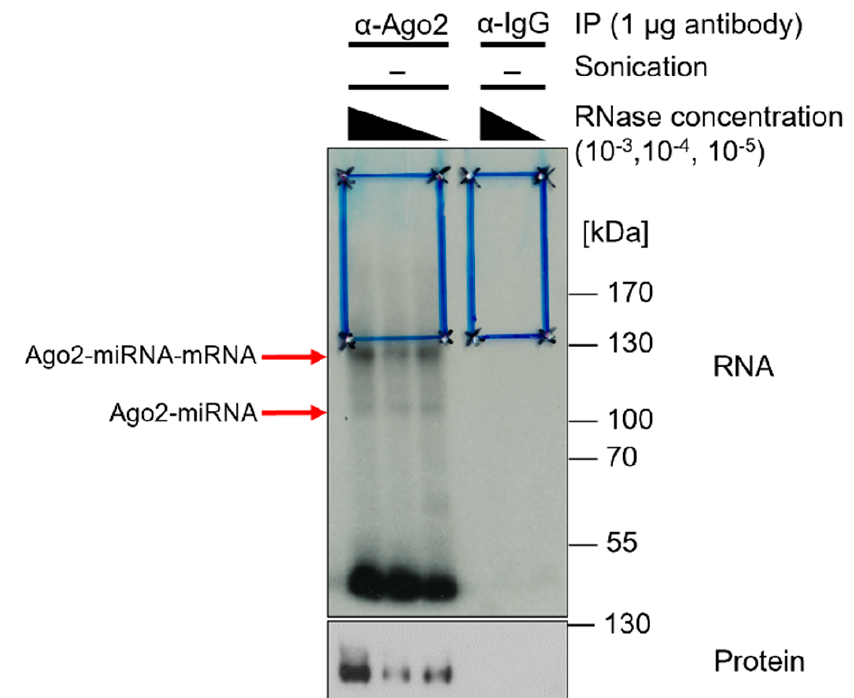
Figure 6. X-ray film of radiography. α -Ago2 clone 11A9 IP and control IP with unconjugated α -IgG (rat) of Calu3 lysates in lysis buffer crosslinked at 254 nm and 450 mJ/cm 2 , sonicated (2 × 15 s, duty cycle/pulse 40%, output control/amplitude 5), and RNase I-digested at concentrations of 10 − 3 , 10 − 4 , and 10 − 5 . Radioactive labeling with ATP mix (1/5 volume [gamma-32P]-ATP). Samples of 20 µ L were loaded with 6 µ L protein marker VI (pre-stained) peqGOLD. NuPAGE gel was run for 150 min at 200 V and transferred onto an Amersham Protran 0.45 µ m NC nitrocellulose membrane for 1 h at 30 V. Then, the sample was exposed to Amersham Hyperfilm MP high-performance autoradiography film for five days. Blue boxes indicate regions of interest on the membrane, which was cut for further processing. Red arrows indicate Ago2-miRNA–mRNA and Ago2-miRNA complexes. Subsequent Western blot on CLIP-membrane. α -Ago2 clone 11A9 (1:500) in 5% milk-TBS-T, followed by α -rat IgG. Exposure with Lumi-Light Plus on Amersham Hyperfilm ECL film.